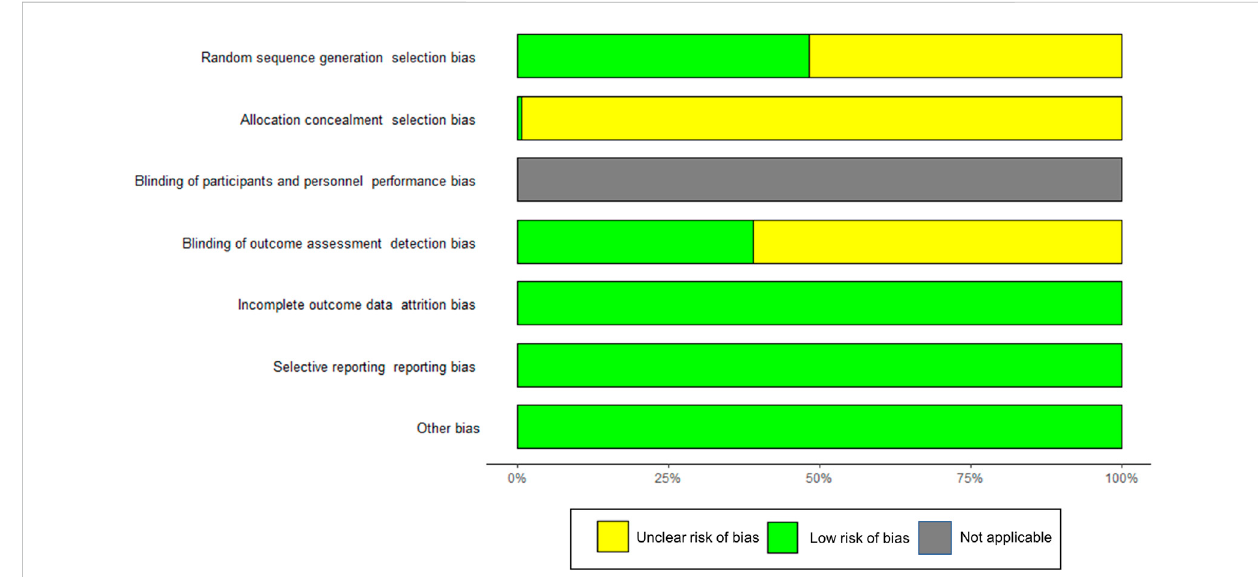
FIGURE 2 RiskassessmentofbiasusingtheCochrane riskofbias.Riskofbiasitemsofall includedstudies areindicatedas thepercentages.Green=low riskof bias, yellow = unclear risk of bias, gray = not